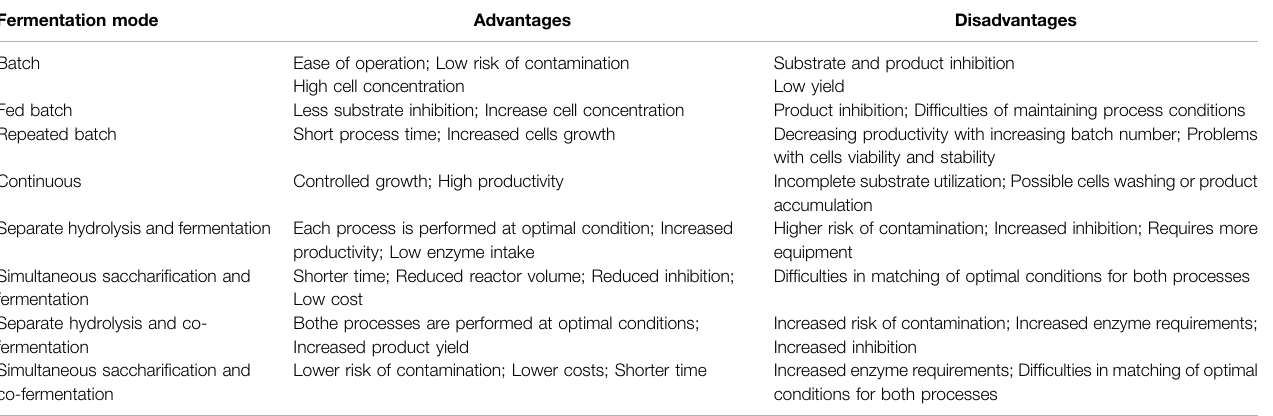
TABLE 5 | Advantages and drawbacks of different process